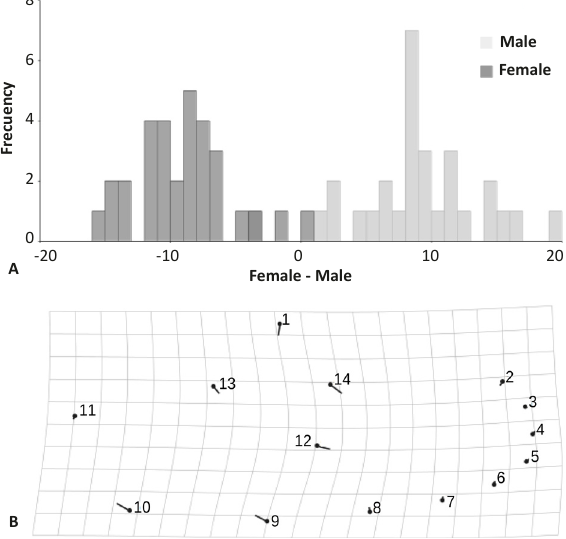
Figure 4. Discriminant analysis for 60 Aedes albopictus wing specimens: A - histogram with the values of the discriminant scores for groups (females and males), and B - the thin-plate spline deformation grid with the differences between females and